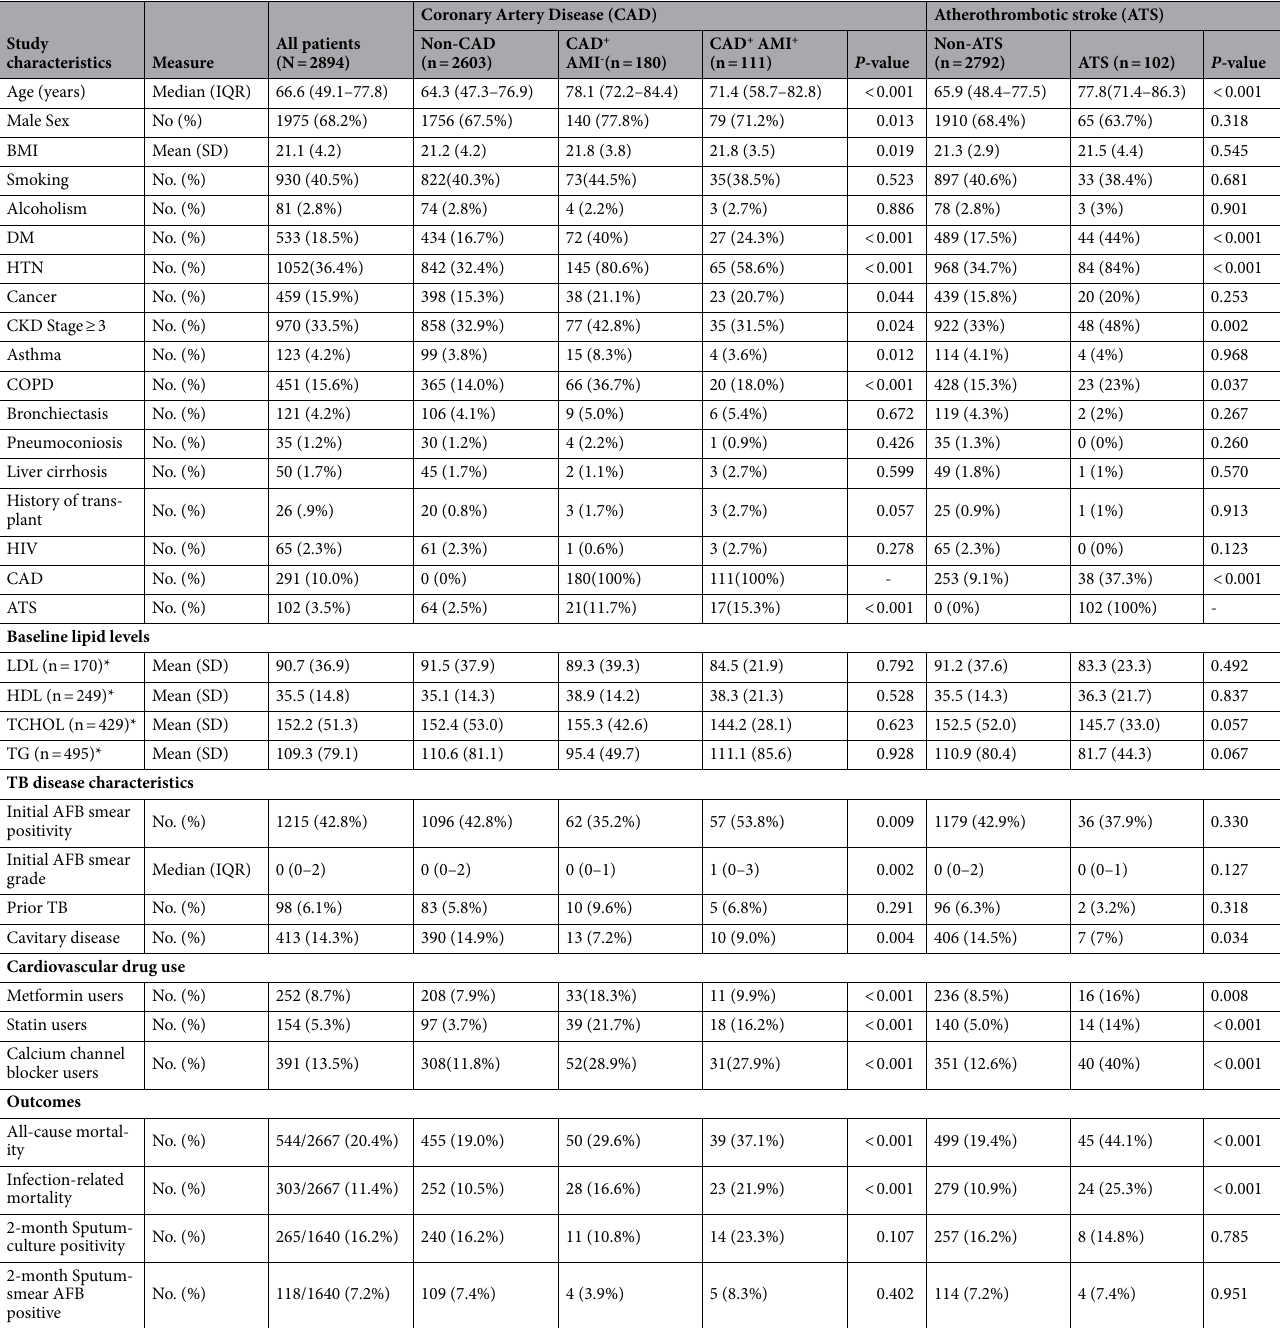
Table 1. Patient characteristics stratified by coronary artery disease (CAD) and atherothrombotic stroke (ATS). AFB: Acid-fast bacilli; BMI: Body mass index; ATS: Atherothrombotic stroke, CAD: Coronary artery disease; CAD + AMI + : Coronary artery disease with history of Acute myocardial infarction; CAD + AMI-: Coronary artery disease without history of Acute myocardial infarction; CCB: Calcium channel blocker; CCI: Charlson comorbidity index; CHF: Congestive heart failure; CKD: Chronic kidney disease; COPD: Chronic obstructive pulmonary disease; CVA: Cerebrovascular accident; DM: Diabetes mellitus; HDL: High density lipoprotein cholesterol; HIV: Human immunodeficiency virus; HTN: Hypertension; IQR, Interquartile range; LDL: Low density lipoprotein cholesterol; PVD: Peripheral vascular disease; SD: Standard deviation. * Lipid levels were available only for a subset of the